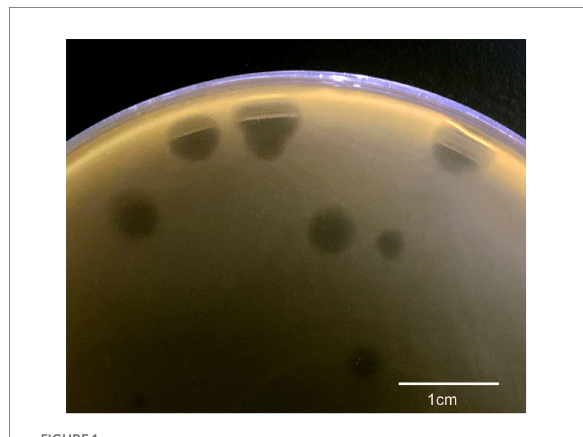
FIGURE 1 Plaque pattern formed by φ PaP11-13 lysis P. acne . The scale bar is 1 cm.